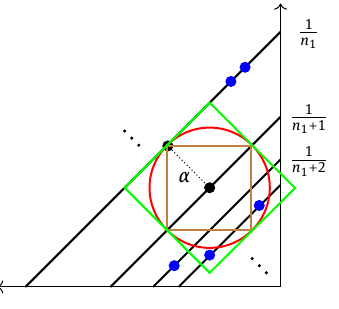
Figure 2: The blue points indicate a finite subset A of X . Having noted to the balls drawn, one can see that if α is the minimum line and the n 1 + 1 th line, which is equal to the distance between the two black points, then distance between points of the n th 1 there obviously exists an α -tree containing A , while for no ε smaller than this distance A is ε -linkable.